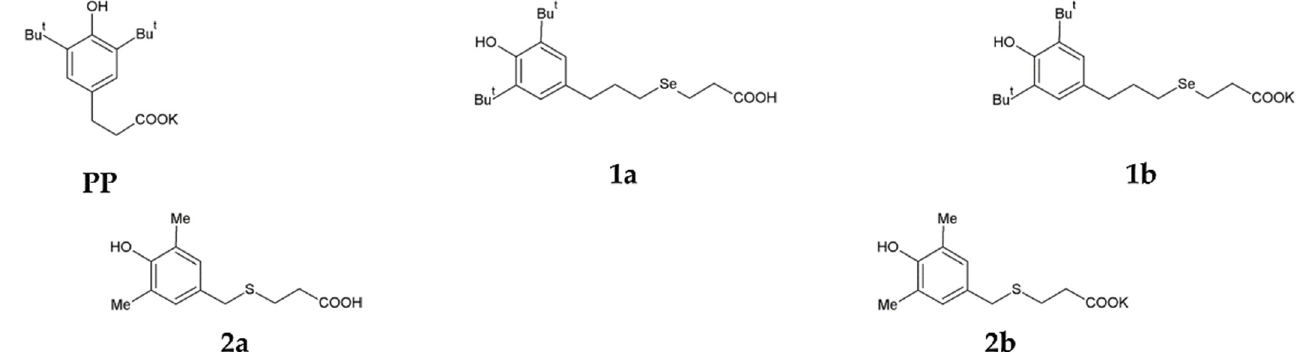
Figure 1. Structural formulas of potassium phenosan [ PP , potassium 3-(3,5-di-tert-butyl-4- hydroxyphenyl)propionate], 3-[3-(3,5-di-tert-butyl-4-hydroxyphenyl)propylseleno]propanoic acid ( 1a ), potassium 3-[3-(3,5-di-tert-butyl-4-hydroxyphenyl)propylseleno]propionate ( 1b ), 2-(3,5-dimethyl- 4-hydroxybenzylthio)propanoic acid ( 2a ) and potassium 3-[4-hydroxy-3,5-dimethylbenzylthio]propanoate ( 2b ). Table 1. The cytotoxicity (LC 50 ) of compounds against HepG2, Hep-2 and MCF-7 cells. The values are the mean of three wells ± standard deviation